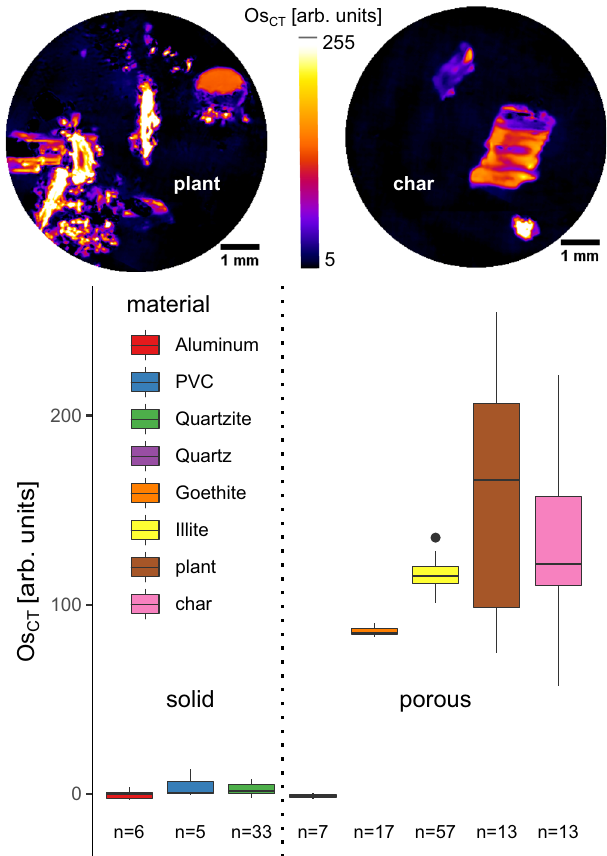
Fig. 3 Normalized Osmium concentrations (Os CT ) in some reference materials in arbitrary units. Some materials are solid and cannot be penetrated by Os vapor. The divergence from zero Os intensity for solid materials can therefore only be explained by polychromatic X-ray artifacts. Other materials are porous, i.e. powders with grain size smaller than the image resolution or biological material within inherent porosity. The boxplots show the 0%, 25%, 50%, 75, and 100% percentiles of varying sample numbers ( n ) after outlier detection. The two images show representative slices through X-ray tomograms of char and plant